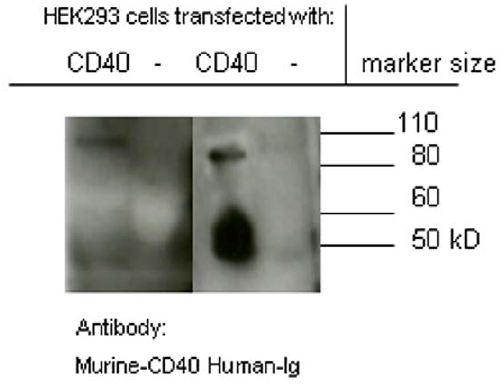
Figure 1. Western blot of supernatant of HEK293 transfected cells showing CD40:Fc expression. HEK293 cells were transduced with AAV2-CD40:Fc or were mock transduced. The fusion protein was detected by anti murine-CD40 (left panel) and anti-human-Fc (right) and showed a band , 90 kD (size of non-reduced dimer) and a , 45 kD (reduced monomer)